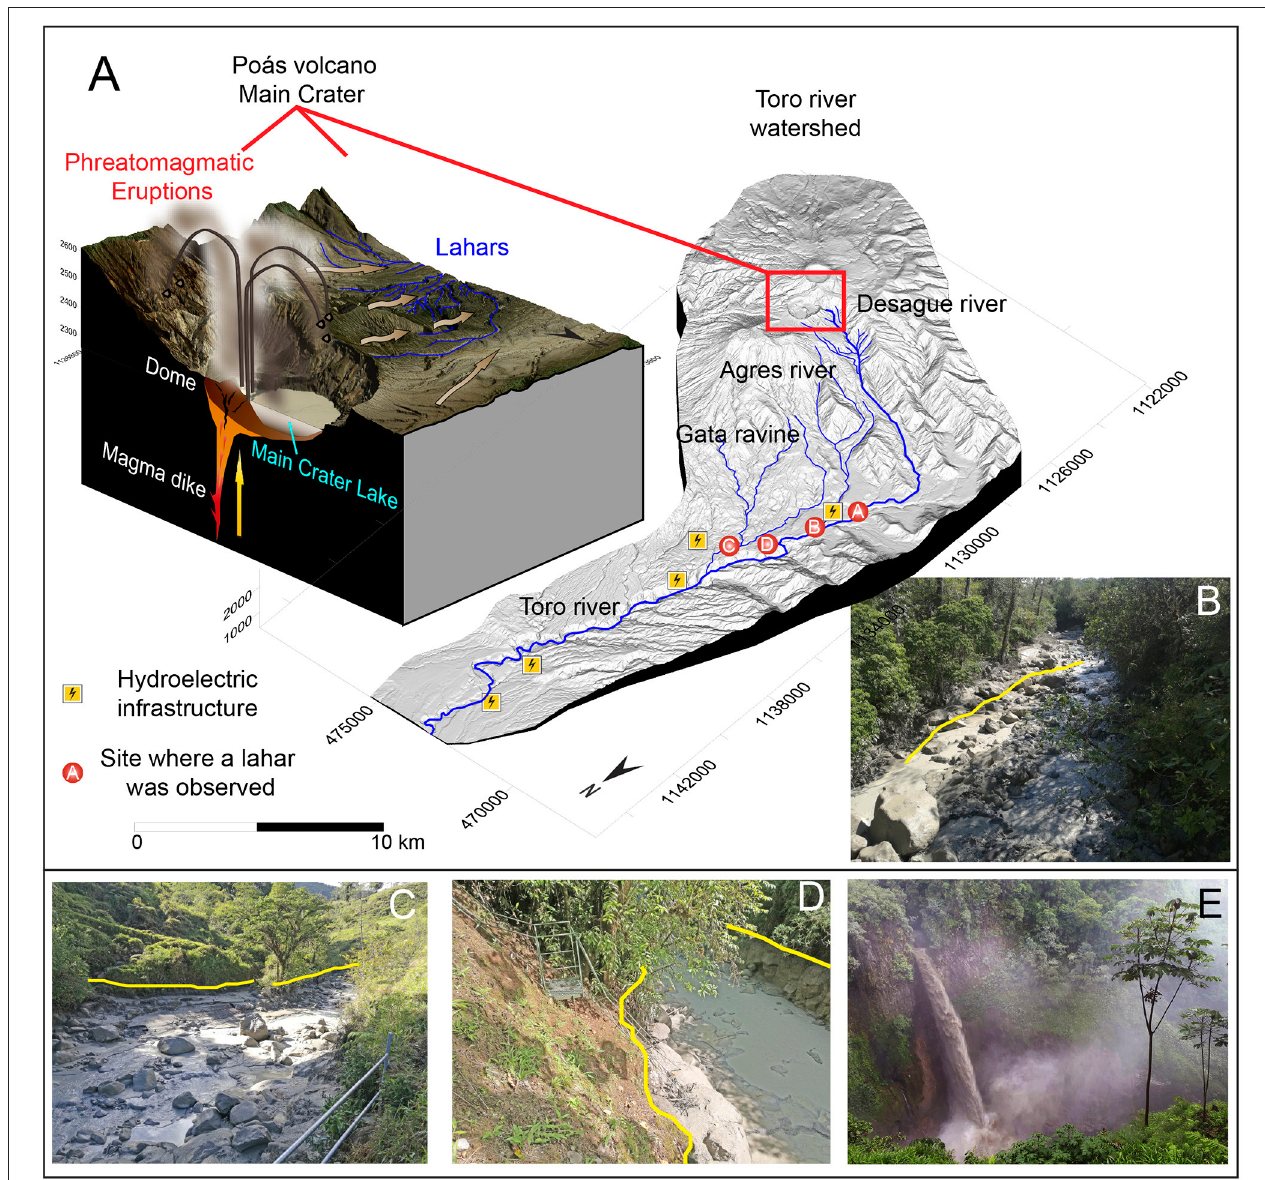
FIGURE 4 | On April 2017, a phreatomagmatic eruption on the Main Crater of Poás Volcano expelled water, sediments and juvenile material into the air. (A) Schematic view of the eruption with a DEM of the Toro River watershed with the location of images where lahars arrived. The yellow lines on the pictures mark the upper limit of the lahar in the river channels (mud line): (B) Desagüe River; (C) Agrio River; (D) Gata Creek; (E) Lahar falling into the Toro River. Water of this waterfall is normally clear and is a tourist